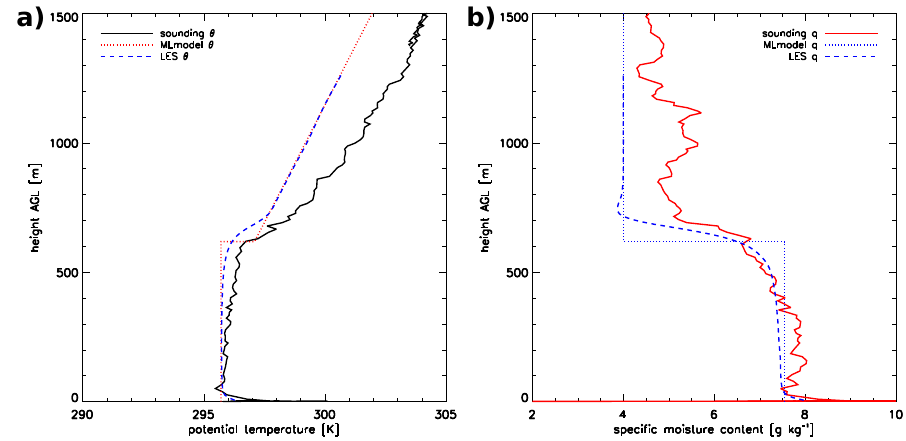
Figure 9. Vertical profile of (a) potential temperature ( θ ) and (b) specific humidity ( q ) at 12:57UTC: frequent radiosounding, DALES and mixed-layer model.